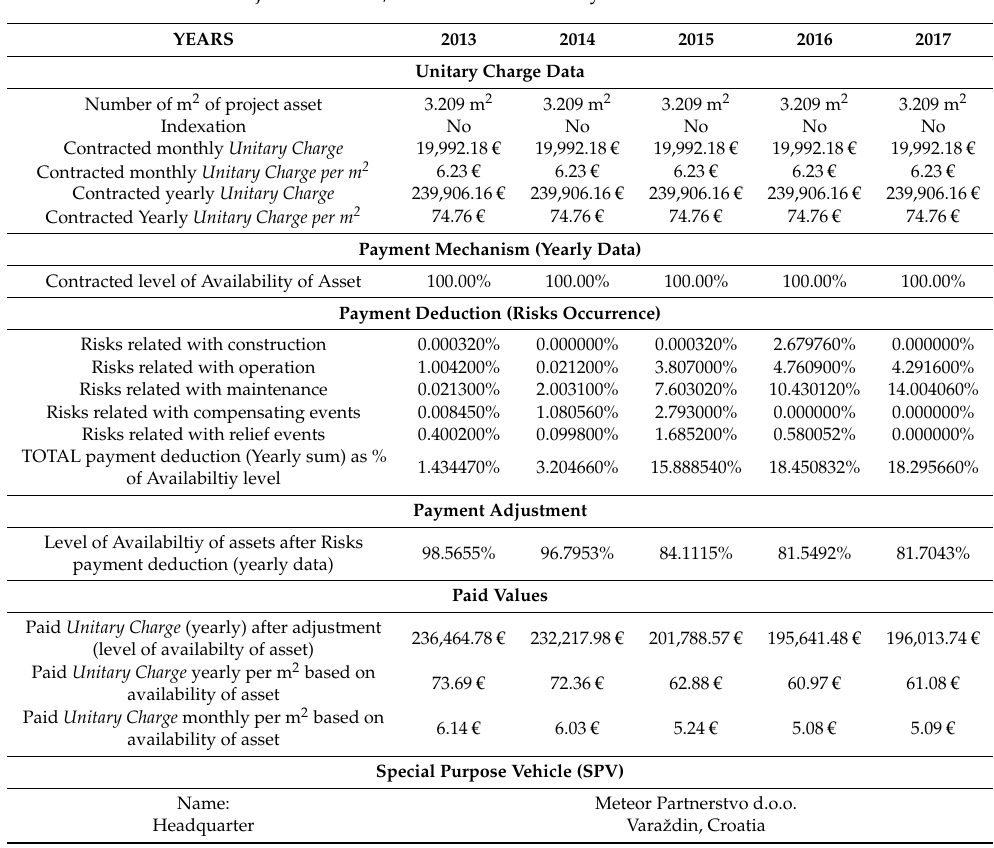
Table A2. Project No. 0004 / 2011—data summary for 2013–2017. Source: